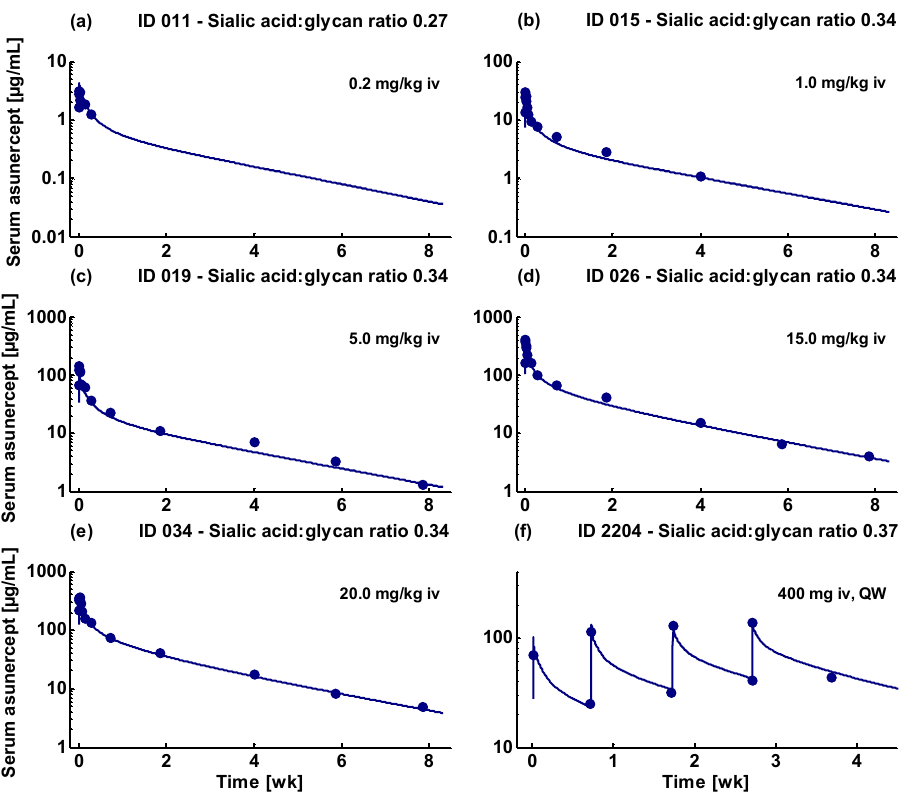
Figure 3. Model performance for intravenous administration of 0.2 mg/kg to 20.0 mg/kg asunercept. Individual simulations are shown as lines, measured asunercept serum concentrations are shown as dots. All presented serum concentration-time profiles are from the training dataset. ( a )–( e ) Asunercept serum concentrations of healthy male volunteers that participated in the Phase I study APG101_CD_001; ( f ) asunercept serum profile of a female glioblastoma patient enrolled in the Phase II study APG101_CD_002. Predicted compared to observed asunercept serum concentration-time profiles of all 51 analyzed individuals are shown in Supplementary Figures S1–S3.